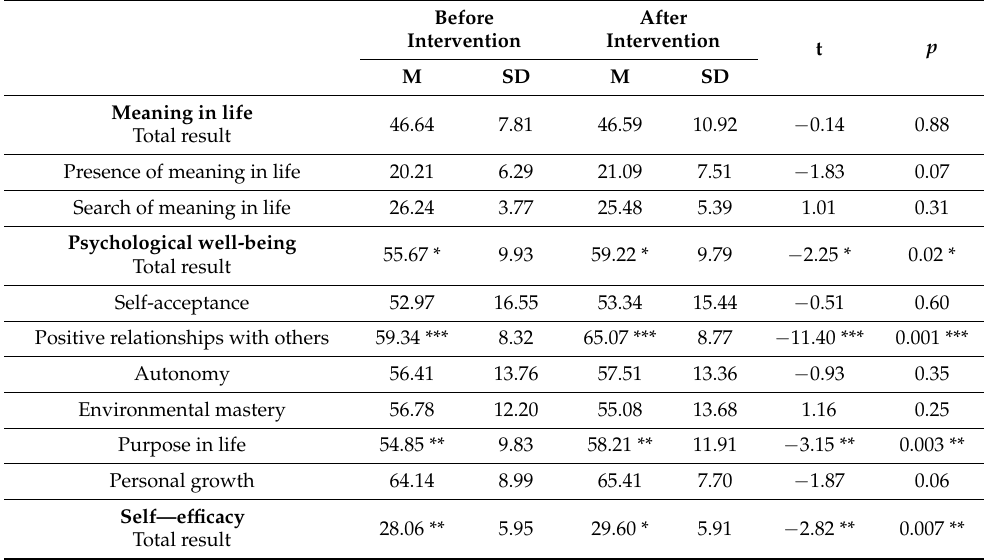
Table 2. Comparison of the level of meaning in life, psychological well-being, and self-efficacy before and after intervention in experimental group (with intervention) ( n = 40).